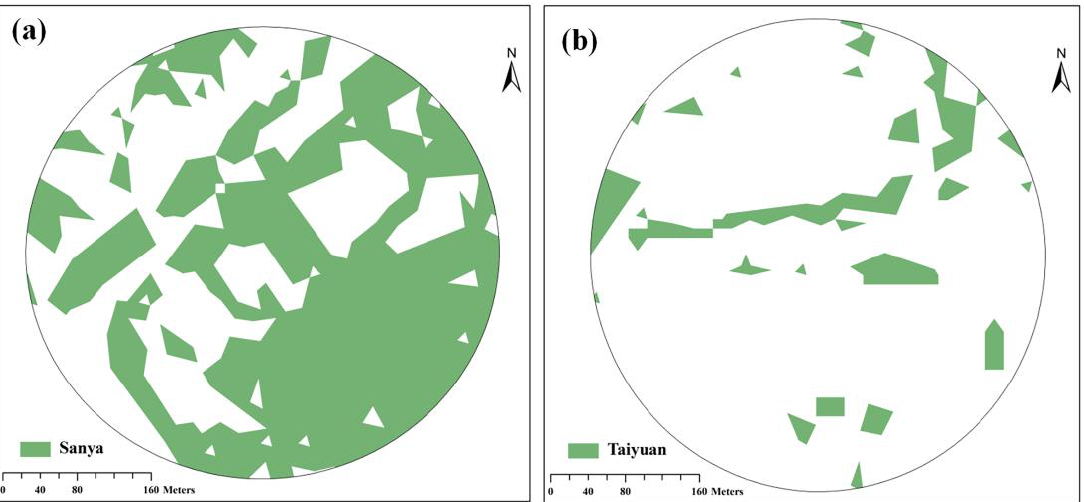
Figure 9. The transformation of two green space compactness types. ( a ) The distribution of green spaces within 250 m of the People’s Bank of Sanya; ( b ) The distribution of green spaces within 250 m of the People’s Bank of Taiyuan.